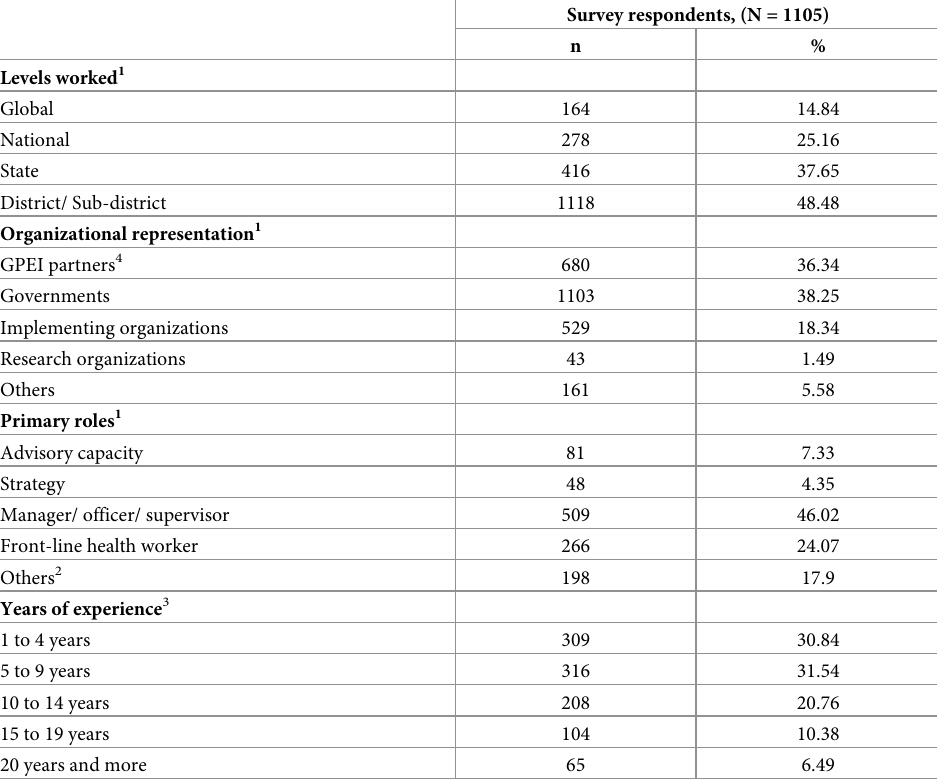
Table 1. Characteristics of respondents involved in community